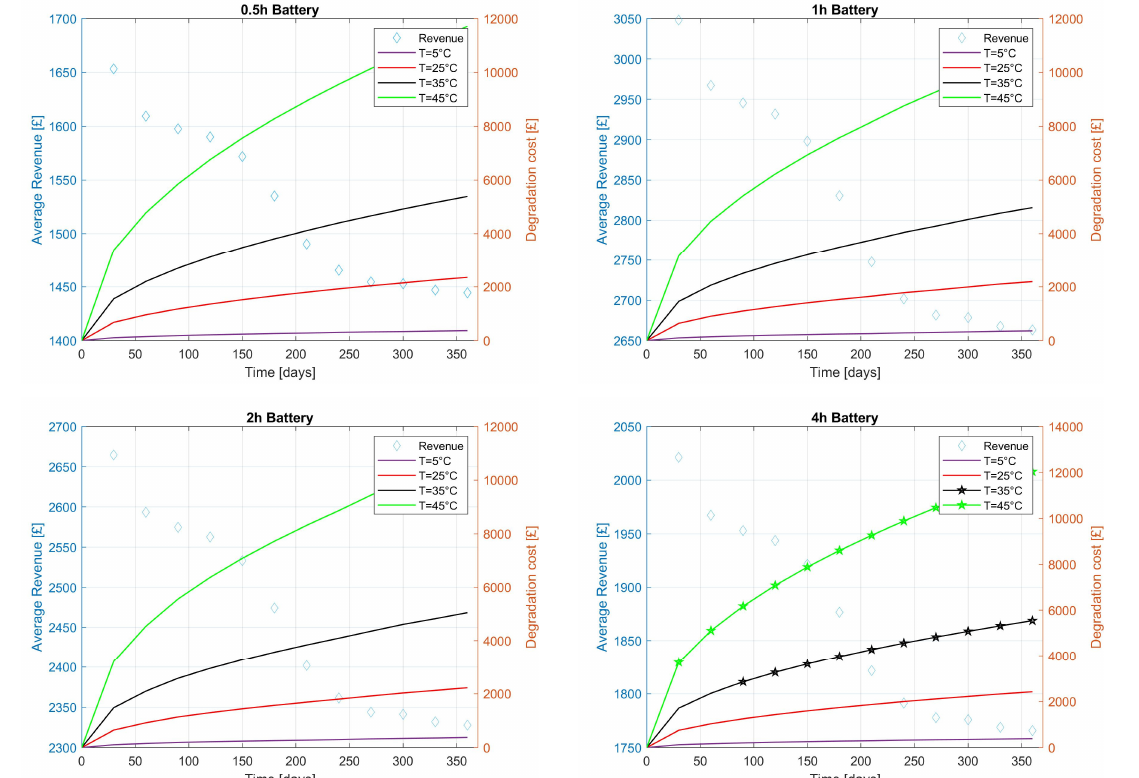
Figure 7. Revenue and degradation costs for four de-rated batteries (0.5 h–4 h) for a one-year capacity market contract with different charge states and T = 25 °C.